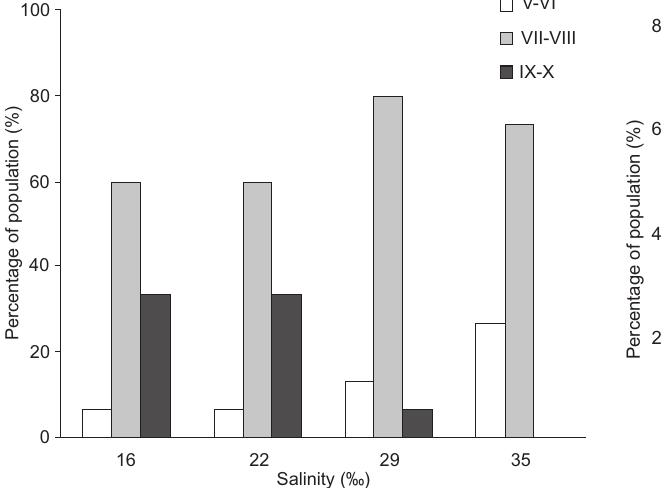
Figure 3. Stage of development (number of molts including meta- ) morphosis, in roman numerals) of F. paulensis postlarvae (PL 18 after 20 days of culture in different test salinities (16, 22, 29, and 35‰) at 24.7 ± 1.6°C, and 388 ind/m 2